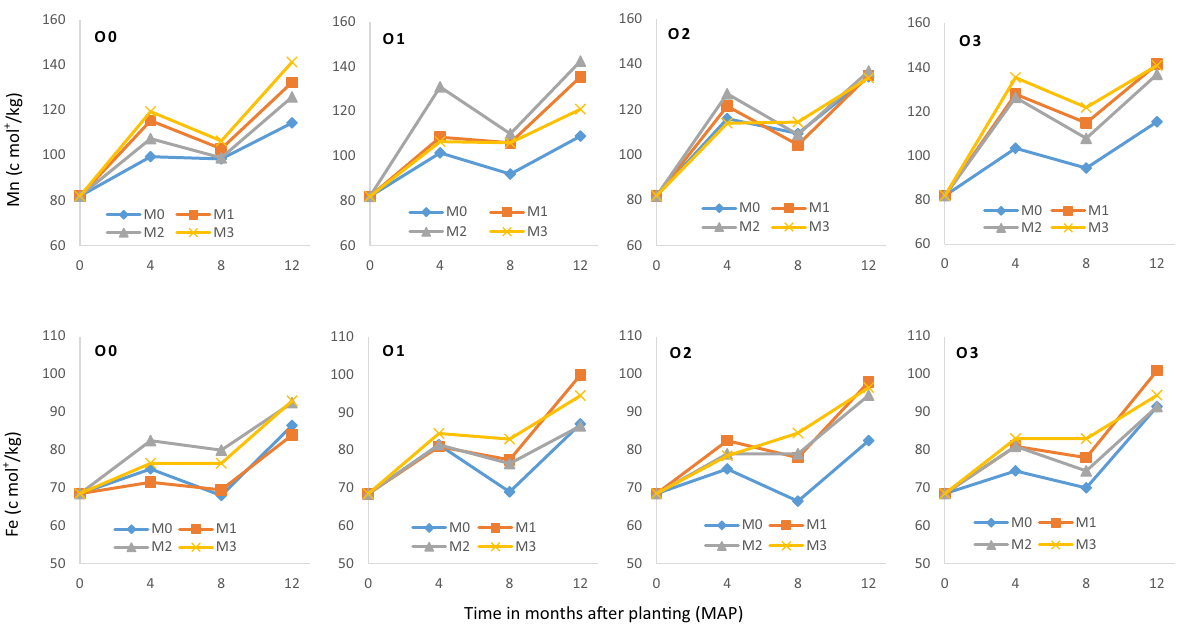
Fig. 4 The interaction effect between organic and mineral fertilizer on Mn and Fe concentration in the